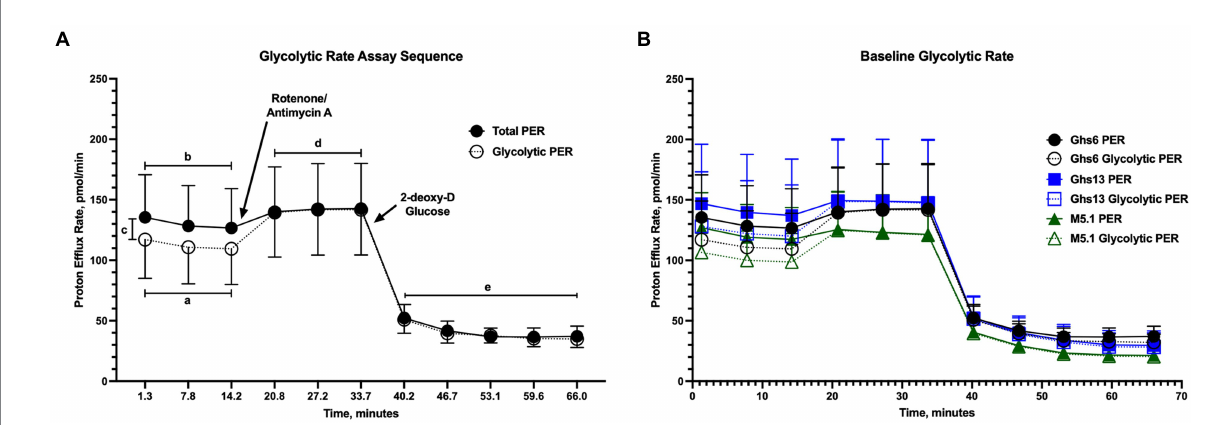
FIGURE 2 (A) Example output for the Agilent Glycolytic Rate Assay run on the Seahorse XFe96 Analyzer (Santa Clara, CA). The assay collects measurements to determine (a) basal glycolysis and (b) basal proton efflux rate (PER) prior to inhibition of mitochondrial oxidative phosphorylation by rotenone/ antimycin A injection into assay media. In these basal measurements, (c) mitochondrial activity is determined as the difference between the total PER and glycolytic PER lines. Following inhibition of mitochondrial contributions to PER, (d) compensatory glycolysis—the ability of cells to utilize glycolysis to meet metabolic needs—is measured before injection of 2-deoxy-D glucose (2DG) into the assay media. Following glycolytic inhibition by 2DG, the assay measures (e) post-2DG acidification as a measurement of residual glycolytic activity. (B) Baseline glycolytic rate assay output in peripheral blood mononuclear cells isolated from 21 day-old Leghorn (Ghs6 and Ghs13) and Fayoumi (M5.1) inbred genetic lines before inoculation with 10X Coccivac-B52 (Merck Animal Health, Kenilworth, NJ) Data represent the mean proton efflux measurement (PER; n = 10 birds/genetic line) ±